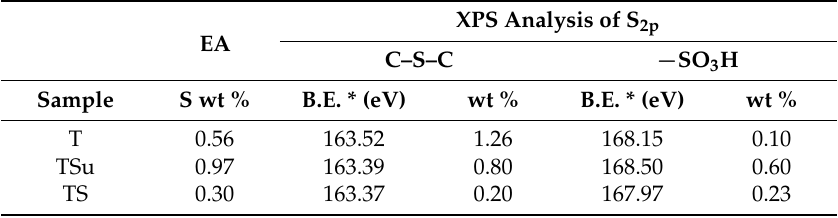
Table 3. Sulphur analysis by Elemental Analysis (EA) and X-ray photoelectron spectroscopy (XPS).